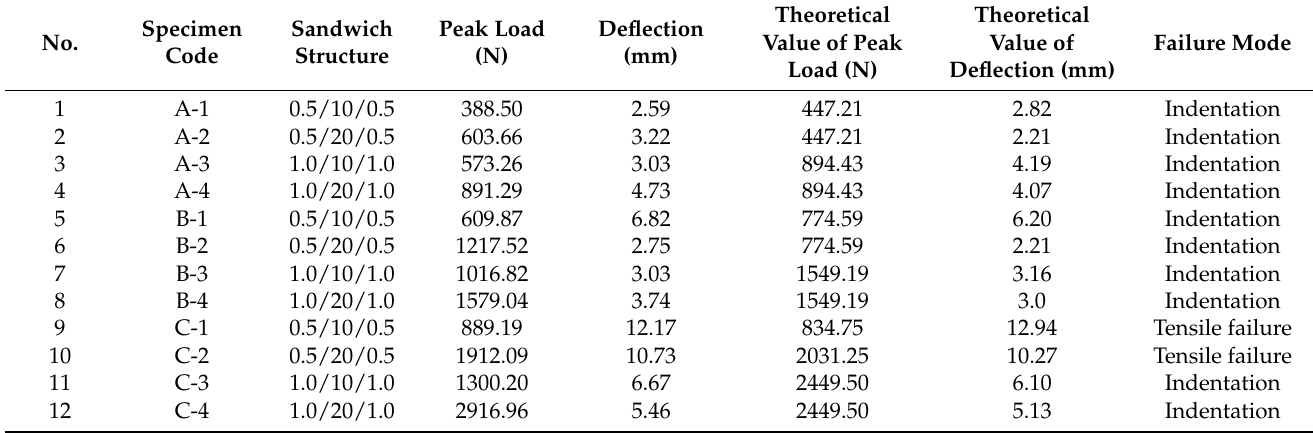
Table 2. Quasi-static experimental